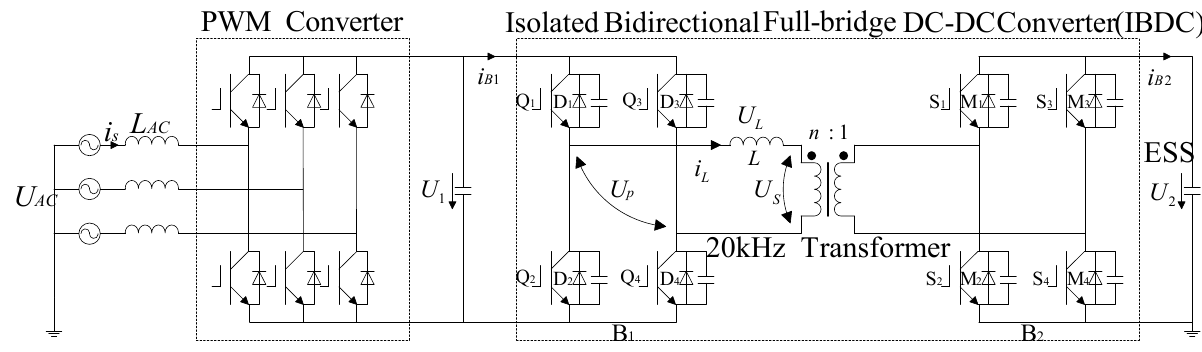
Figure 2. Energy storage system based on IBDC in a